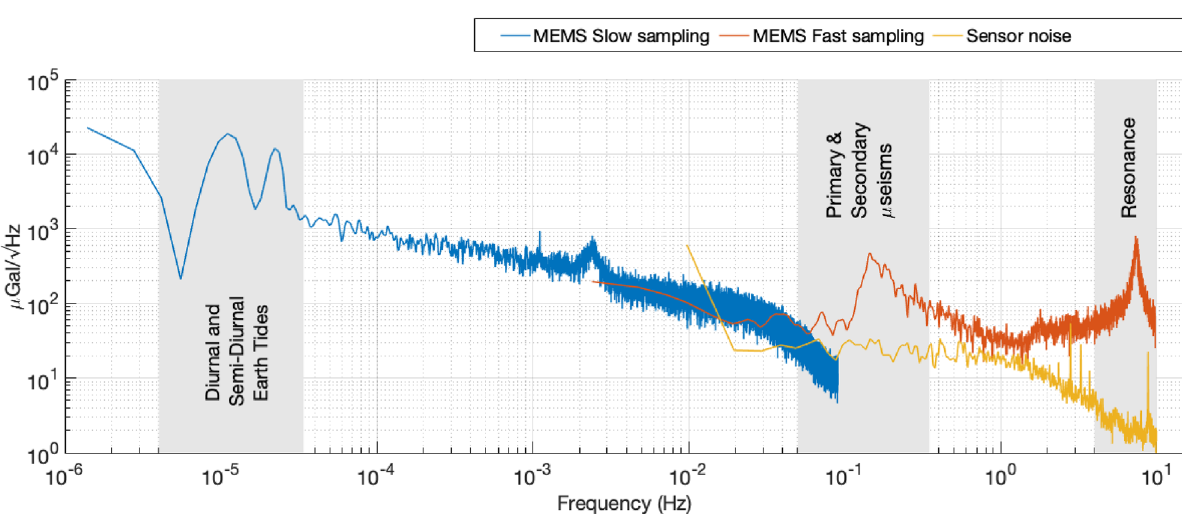
Figure 3. An amplitude spectral density plot of the post-regression instrument data (the blue and the orange series), and the instrument noise data (the yellow series). The blue series represents data that were recorded at a sampling rate of 0.18 Hz. The orange and the yellow series were recorded at a sampling rate of 20 Hz. Three distinct frequency bands of interest can be observed in the data—these are highlighted using the grey bands. 5 At 10 − Hz, the diurnal and semi-diurnal components of the Earth tides are visible; the primary and secondary microseisms can be observed at around 0.2 Hz; and the resonant peak of the MEMS device itself is located at 7.35 Hz. The sensor noise has a flat spectral response for the measured bandwidth. Note: The downward roll-off at high frequencies for the blue and the yellow series is due to low-pass filtering at the demodulation